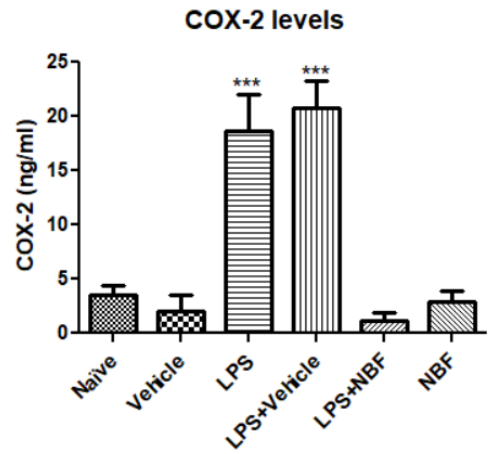
Figure 4. NBF affects COX-2 protein level in RAW264.7 macrophages following LPS stimulation. RAW 264.7 macrophages were exposed to 20 ng/mL LPS and simultaneously with the NBF, 20 µg/mL. COX-2 levels were measured by ELISA using standard calibration curve and are presented as the mean ± SD. Four replicates in each group ( n = 4). ANOVA followed by Bonferroni’s post hoc test was performed. *** p < 0.001 compared to all other groups.